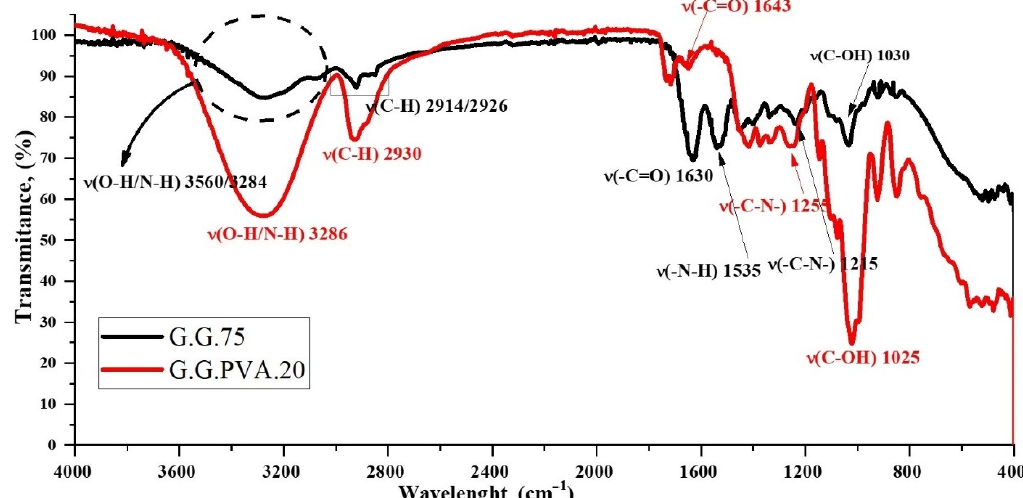
Figure 5. IR spectra of gelatin-based polymer (G.G.75) and poly (vinyl alcohol) (PVA)-based polymer (G.G.PVA.20).